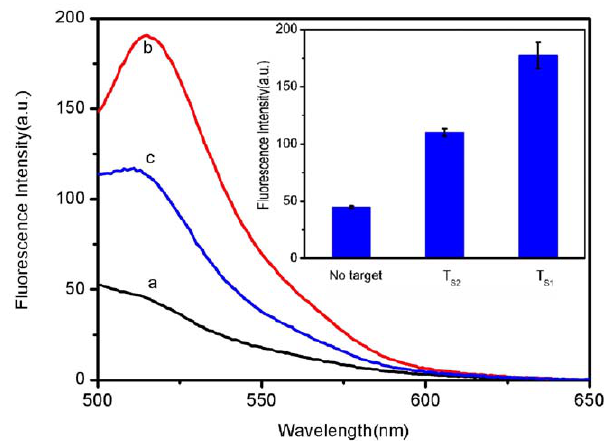
Figure 6. Evaluation of discrimination ability using shorter probe. Fluorescence emission spectra of P S (50 nM) at different conditions: (a) P S -RCPN complex; (b) P S -RCPN complex + 300 nM T S1 ; (c) P S -RCPN complex + 300 nM T S2 . Inset: fluorescence intensity histograms with error bar. Excitation was at 480 nm, and the emission was monitored at 518 nm. All measurements were done in Tris-HCl buffer in the presence of 15 mM Mg 2 + (pH: 7.4). The error bar represents the standard deviation of three measurements. doi:10.1371/journal.pone.0030426.g006 effectively quench dyes of different emission frequencies. Figure 9 shows the fluorescence intensity histograms of the probe mixture toward different target combinations in the presence of RCPNs under excitation/emission wavelengths of 480/518, 587/615, and 643/660 nm/nm. It is clearly seen that the addition of T 1 gives only one strong emission peak at 518 nm when excited at 480 nm. However, the target combination of T 1 + T 5 gives two strong emission peaks at 518 and 615 nm when excited at 480 and 587 nm, respectively. Three strong emission peaks are observed for the T 1 + T 5 + T 6 target combination at 518, 615, and 660 nm when excited at 480, 587, and 643 nm, respectively. Based on all